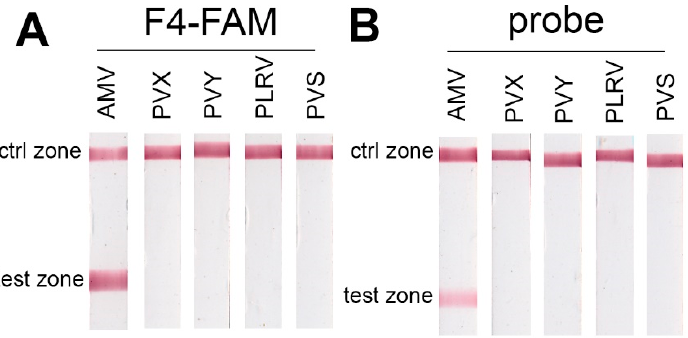
Figure 4. Test of specificity RT-RPA-LFT with AMV, PVX, PVY, PLRV, and PVS: ( A ) when labeled primers were used; ( B ) when THF probe was used.